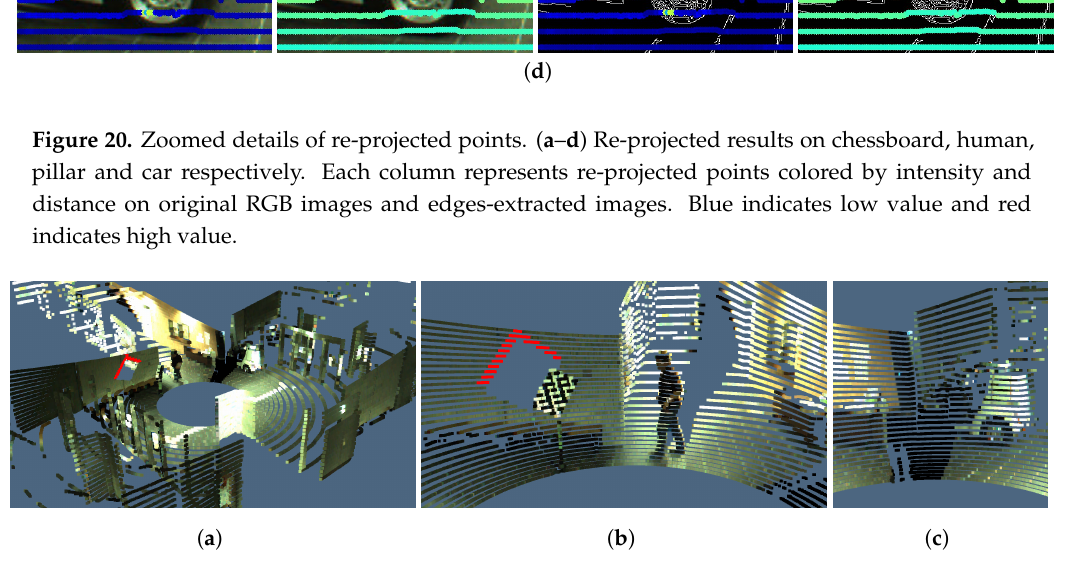
Figure 21. Projection of the RGB information from the image to the point cloud with the estimated extrinsic parameters. ( a ) An example of the colored point cloud; ( b ) The zoomed view of the chessboard in ( a ). The red points in ( a , b ) are occluded region caused by the chessboard; ( c ) The zoomed view of the car in ( a